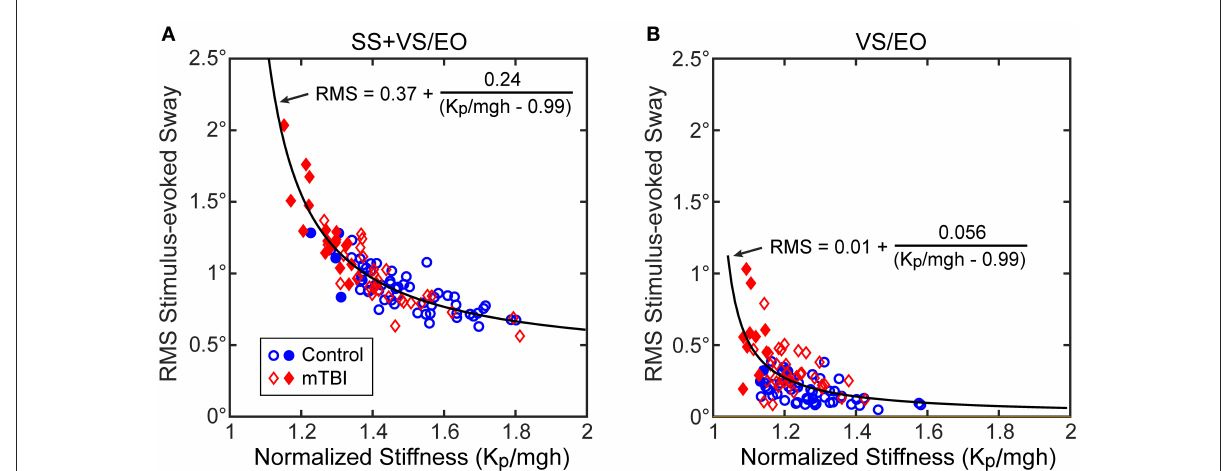
FIGURE4 Relationships between the RMS value of stimulus-evoke CoM sway and normalized stiffness ( K p / mgh ) in (A) the SS + VS/EO test condition (simultaneous pseudorandom surface and visual tilt stimuli) and in (B) the VS/EO test condition (visual stimulus only). Data are from control subjects (blue circles) and mTBI subjects (red diamonds) with filled symbols indicating the 4 control and 19 mTBI subjects in the SS + VS/EO condition and the 2 control and 10 mTBI subjects in the VS/EO condition identified as having both low stiffness and long time delays based on 10 th percentile and 90 th percentile values of control subject data for normalized stiffness and time delay parameters, respectively (see Figure 7). Fits to the combined control and mTBI data of a hyperbolic curve are based on the expected relationship between stimulus-evoked sway and K p / mgh based on the prediction of the simplified balance control model shown in Figure 3.